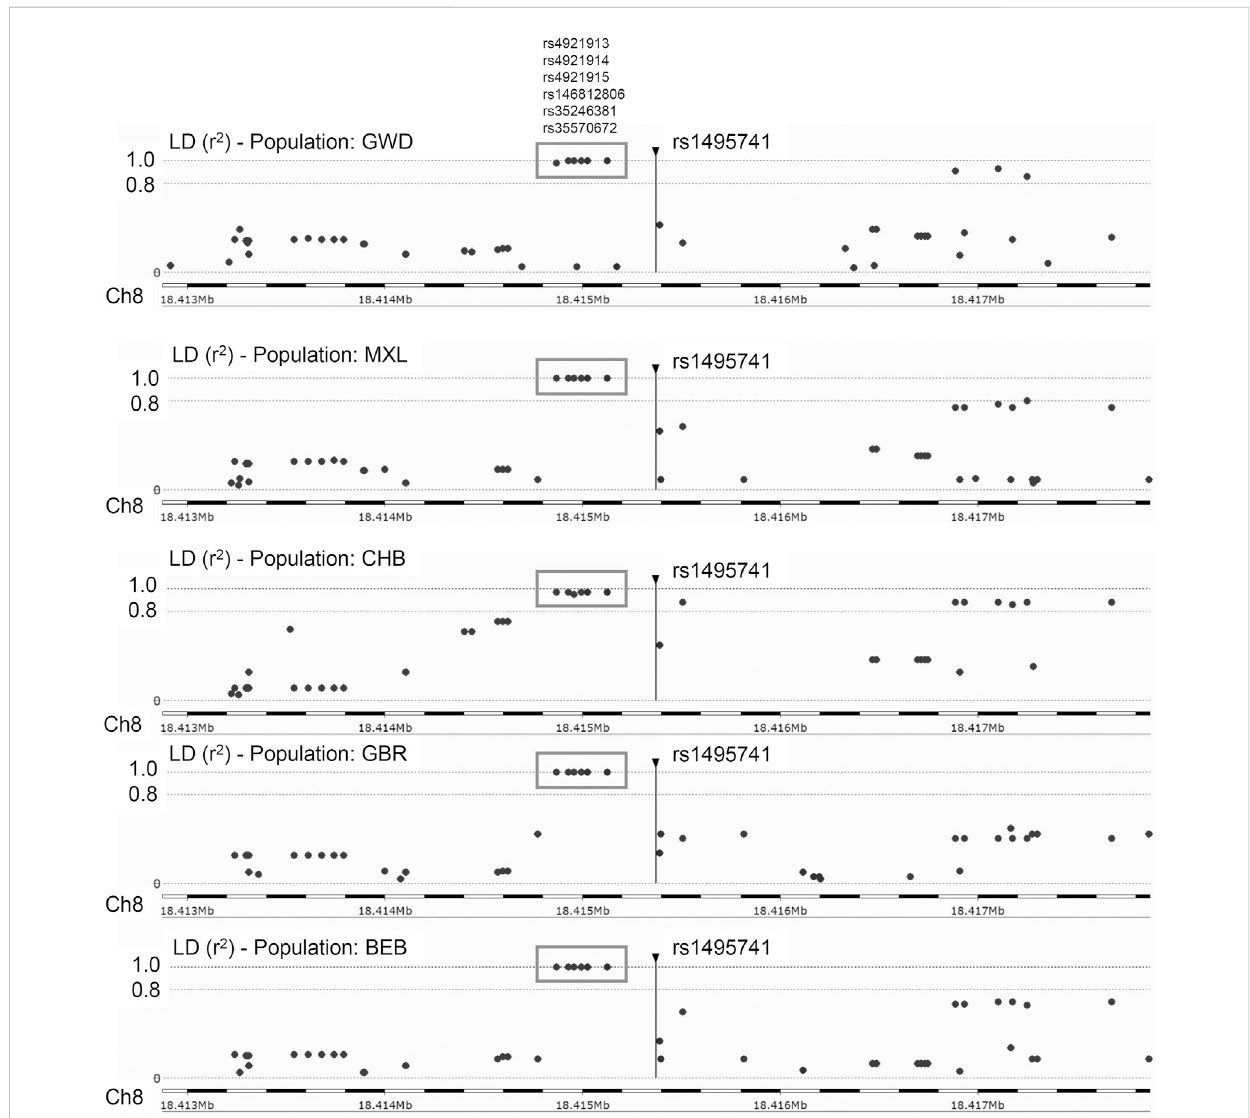
FIGURE 1 Linkage disequilibrium (LD) plots for rs1495741 in representative populations from 1000 Genomes Project. The plots show variants that are (or are not) in linkage disequilibrium with rs1495741. Each dot represents a variant (in a surrounding 5-kb region). The longitudinal dotted lines show LD r 2 value of 1.0 and 0.8, with respect to rs1495741. Numbers on the bottom axis show the location on human chromosome 8 (GRCh38/hg38). The position of rs1495741 is represented by a vertical line. Six variants in the grey box (i.e., rs4921913, rs4921914, rs4921915, rs146812806. rs35246381, and rs35570672)areinlinkagedisequilibriumwithrs1495741with r 2 valueof~1.0inmultiplehumanpopulationsfrom1000GenomesProject(1000Genomes Project Consortium et al., 2015). GWD, Gambian in Western Division; MXL, Mexican Ancestry in Los Angeles; CHB, Han Chinese in Beijing, China;